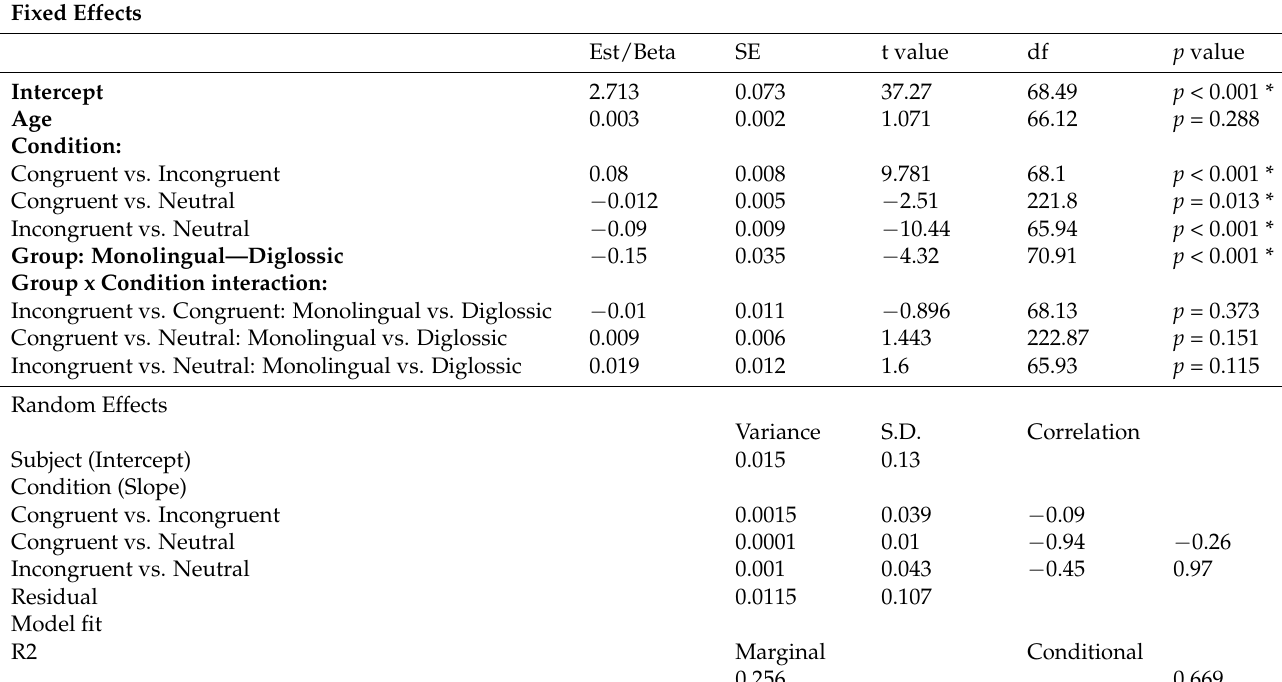
Table 2. Reaction time results for the Flanker